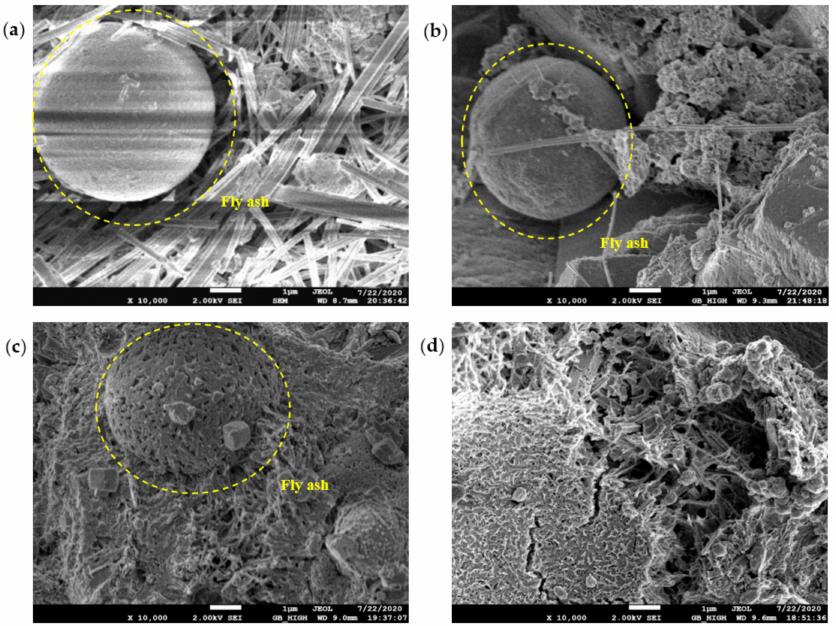
Figure 13. SEM diagram of pure cement paste (FA replacement ratio is 30%) at 28 days of age: ( a ) pH = 7.6 OW; ( b ) pH = 9.5 AEW; ( c ) pH = 10.5 AEW; ( d ) pH = 11.5